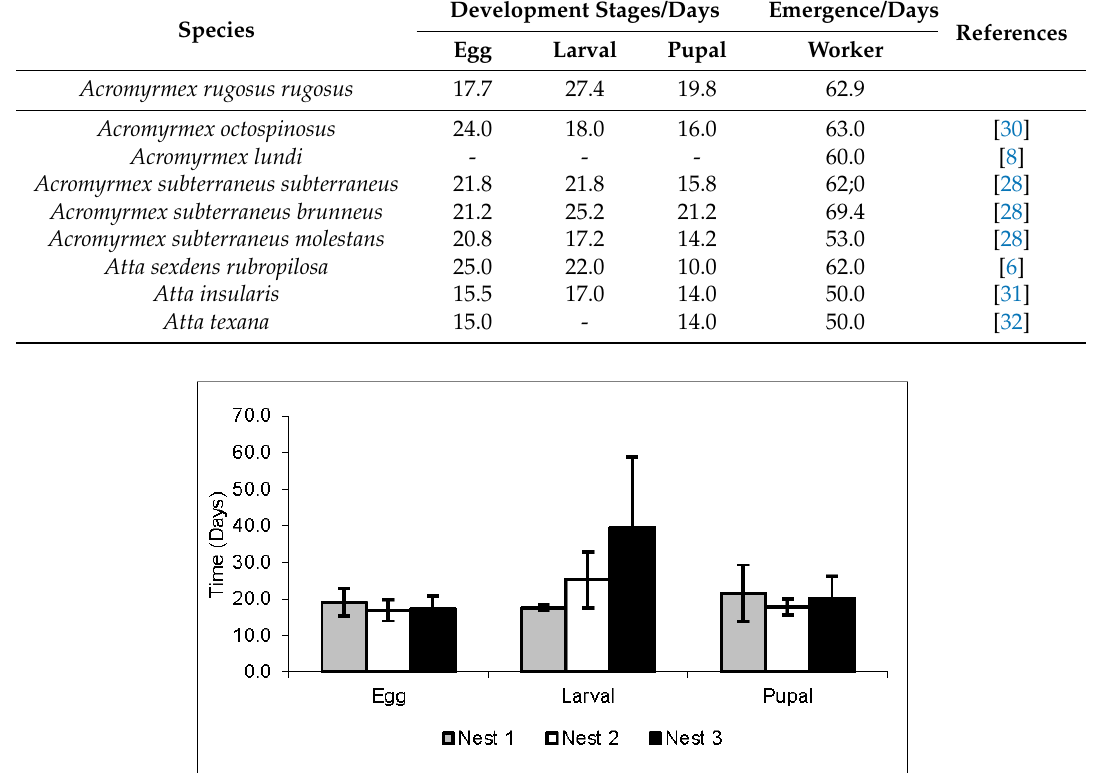
Table 2. Average duration of the offspring development stages and average time of worker development (emergence) observed in Acromyrmex rugosus rugosus in the present study and in other leaf-cutting ants already studied.